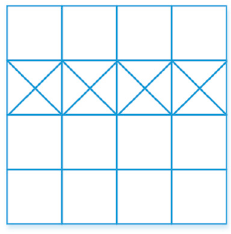
Figure 1. Example of the monitored area, which is divided into 4 × 4 grids.